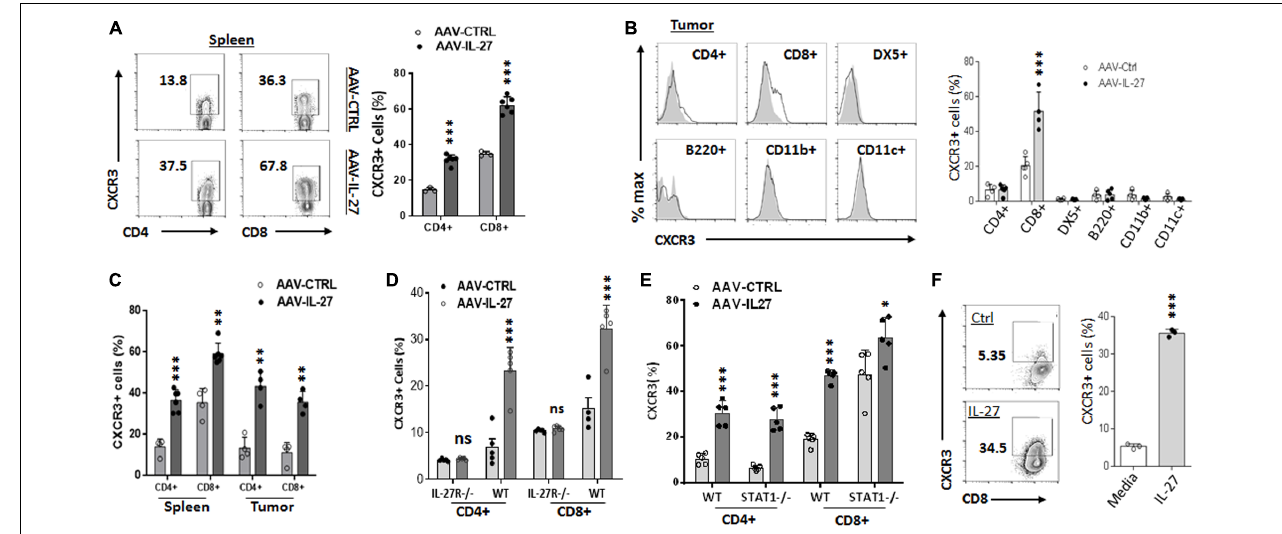
FIGURE 4 | AAV–IL-27 therapy induces CXCR3 expression in T cells. (A,B) C57BL6 mice were injected with B16.F10 tumor cells (2 × 10 5 /mouse) s.c. 7 days later, mice were treated with AAV–IL-27 or AAV-ctrl virus intra-tumorally at a dose of 2 × 10 11 DRP/mouse. Three weeks after AAV injection, mice were sacrificed and their spleens (A) and tumors (B) were analyzed for the expression of CXCR3 in T lymphocytes and other leukocytes by flow cytometry. (C) J558 cells (5 × 10 6 ) were injected into BALB/c mice s.c. Five days later, mice were treated with AAV-IL-27 or AAV-ctrl virus intra-tumorally at a dose of 1 × 10 11 DRP/mouse. Three weeks after viral injection, mice were sacrificed and their spleens and tumors were analyzed for the expression of CXCR3 in T lymphocytes by flow cytometry. (D) C57BL6 and IL-27R − / − mice were injected with B16.F10 tumor cells (2 × 10 5 /mouse) s.c. Seven days later, mice were treated with AAV–IL-27 or AAV-ctrl virus intra-tumorally at a dose of 2 × 10 11 DRP/mouse. 21 days after viral injection, mice were sacrificed and their spleens were analyzed for T cell expression of CXCR3 by flow cytometry. (E) AAV-IL-27 or AAV-ctrl virus (2 × 10 11 DRP/mouse) was injected into Stat1 − / − or control BALB/c mice i.m. Three weeks after AAV injection, T cell expression of CXCR3 in spleens was analyzed by flow cytometry. (F) Spleen cells from P1CTL Tg mice were activated with P1A peptide (0.1 µ g/ml) for 5 days in vitro in the presence or absence of IL-27 (50 ng/ml), and CXCR3 expression on P1CTL cells were analyzed by flow cytometry on day 5. Ns: no significant difference. *** P < 0.001 by One-way